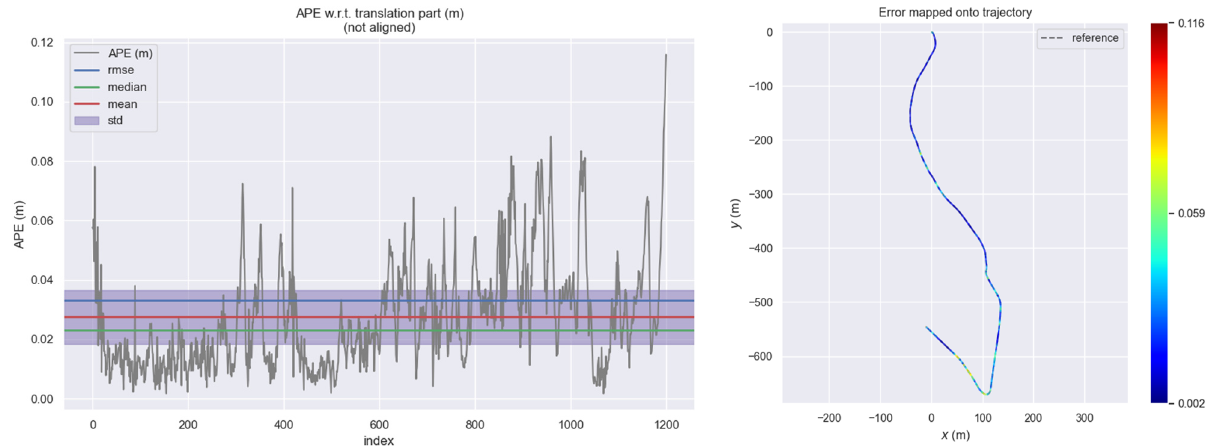
Figure 15. APE result and trajectory of KITTI dataset 10.